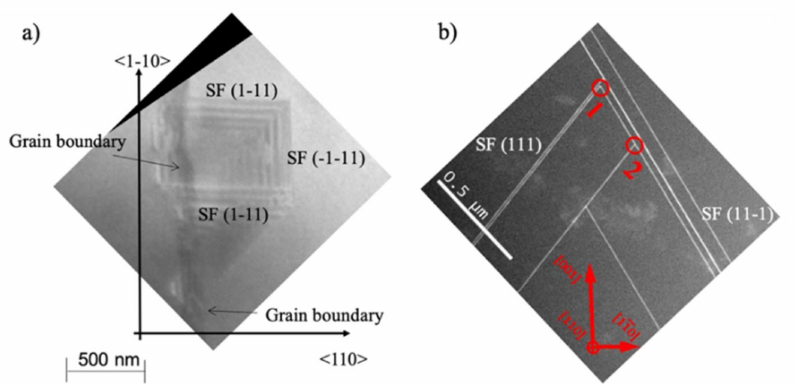
Figure 11. ( a ) TEM image in in-plane view shows four stacking faults that are generated from a grain boundary. ( b ) TEM image in cross-view showing the annihilation of the SF with two different structures (adapted from References [40,60]).